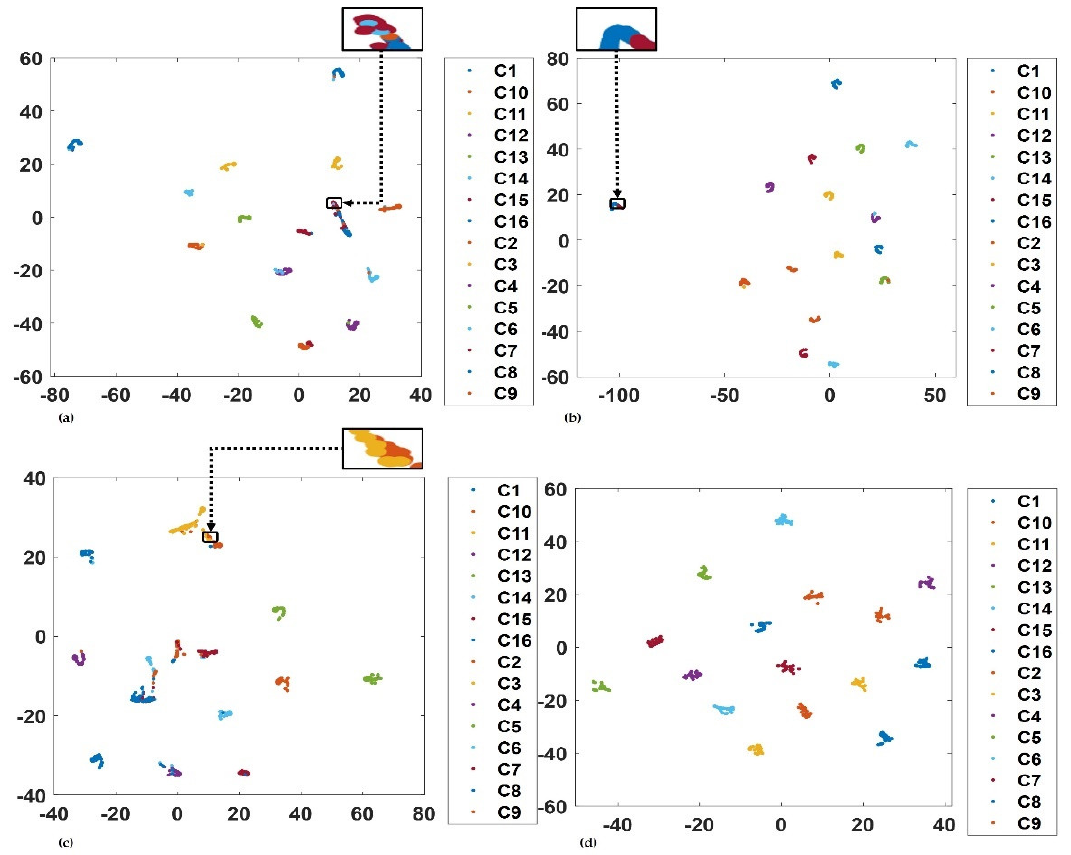
Figure 14. T-SNE representation for the last layer of the base learner: ( a ) SK-CNN, ( b ) CSC-CNN, ( c ) BICO-CNN, and ( d ) proposed method. Table 5. Comparison of the proposed approach with other ensemble deep learning